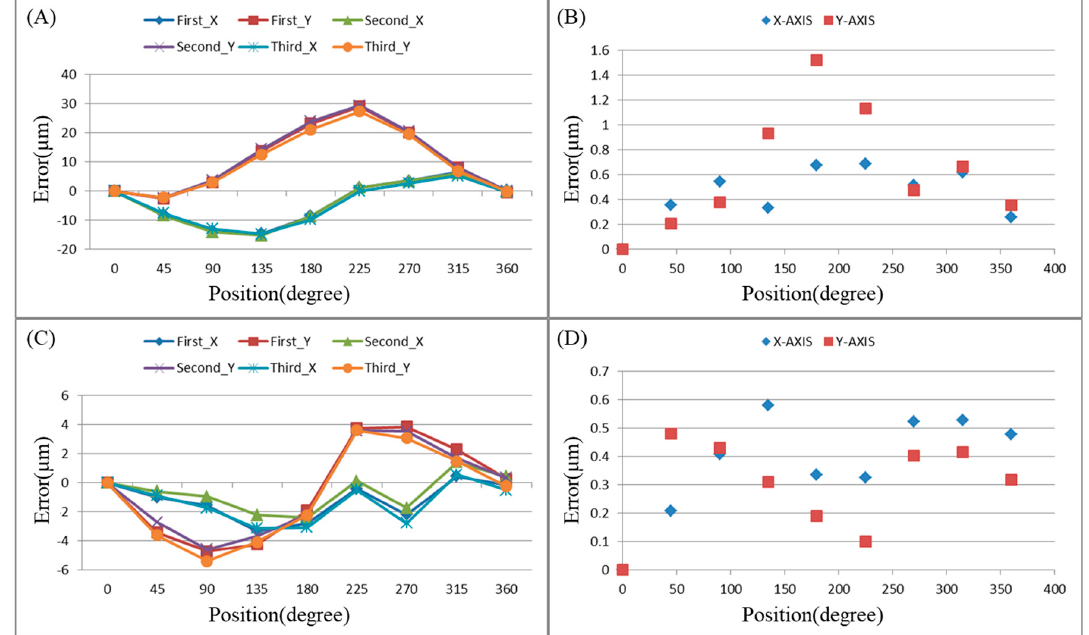
Figure 8. C-axis eccentricity measurement results: ( A ) BK2 path static measurement repeatability before compensation, ( B ) BK2 path static measurement standard deviation before compensation, ( C ) BK2 path static measurement repeatability after compensation, and ( D ) BK2 path static measurement standard deviation after compensation.